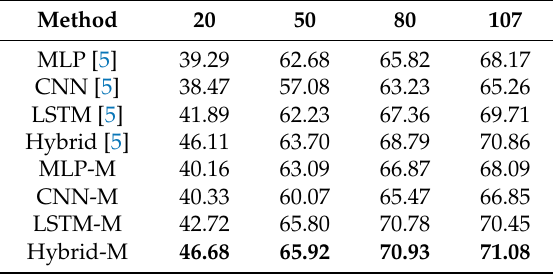
Table 5. The average F1-score (in percent) using different numbers of sensor channels on the OPPORTUNITY